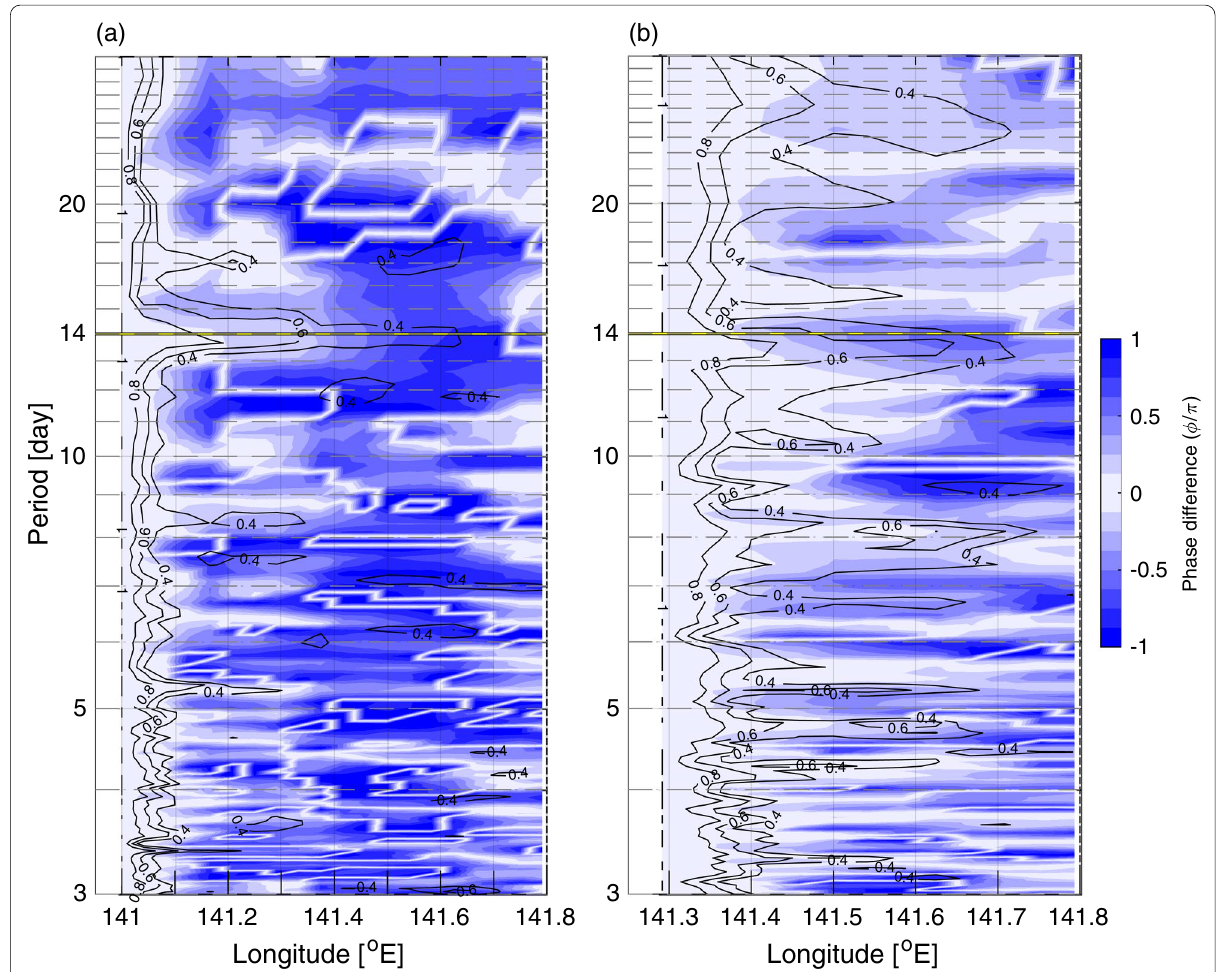
Fig. 8 Phase difference (color) and coherence (contours) of variation for the axis latitude estimated from the high-frequency radar data at each subgrid in relation to that at a 141°E and b 141.3°E for